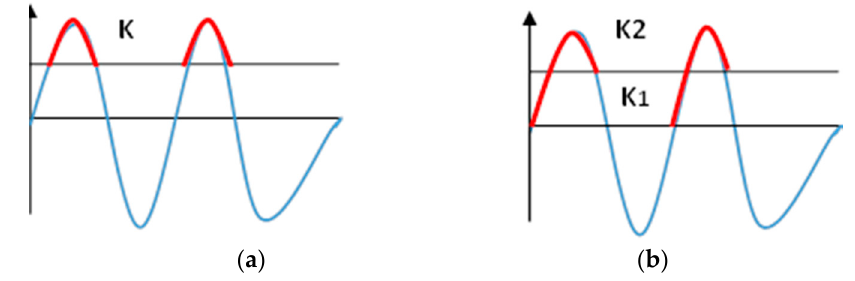
Figure 3. ( a ) Single threshold and ( b ) double threshold.